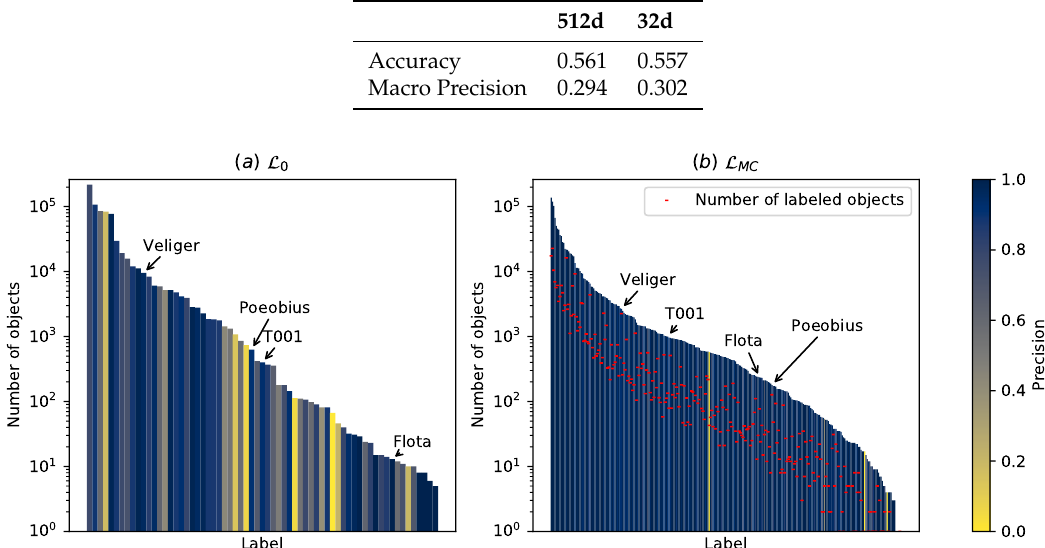
Table 1. Accuracy and macro precision of the classifier trained for feature extraction before (512d) and after dimensionality reduction (32d). Dimensionality reduction did not substantially change the capacity of the classifier.